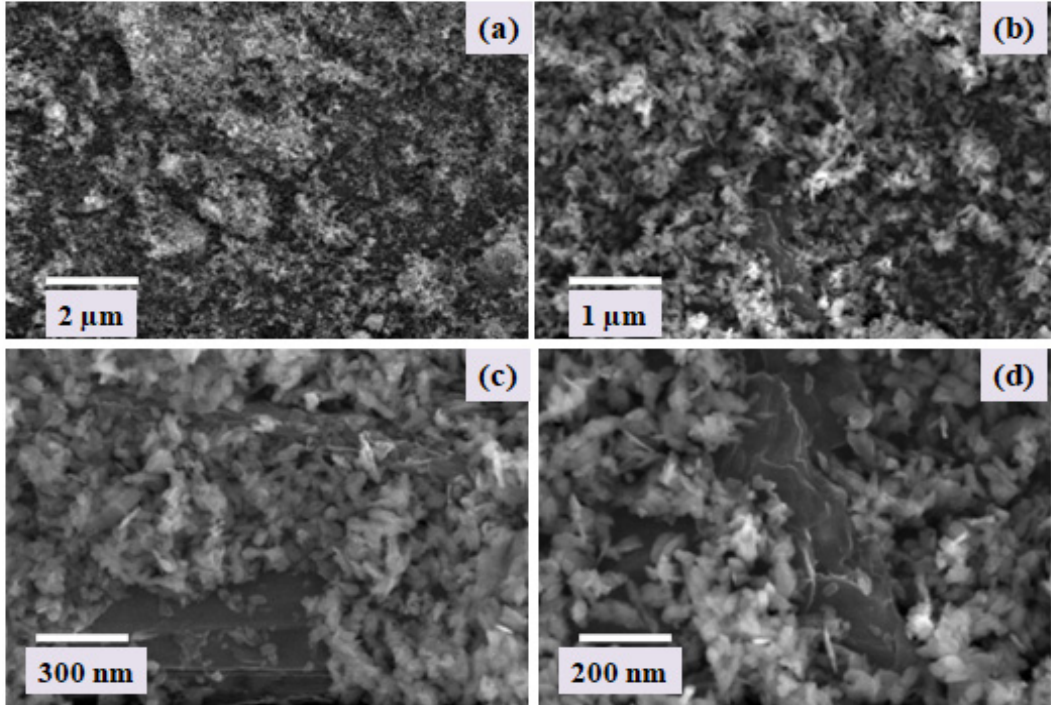
Figure 2. FESEM images of ( a – d ) rGO-CuO nanocomposites with different magnifications.